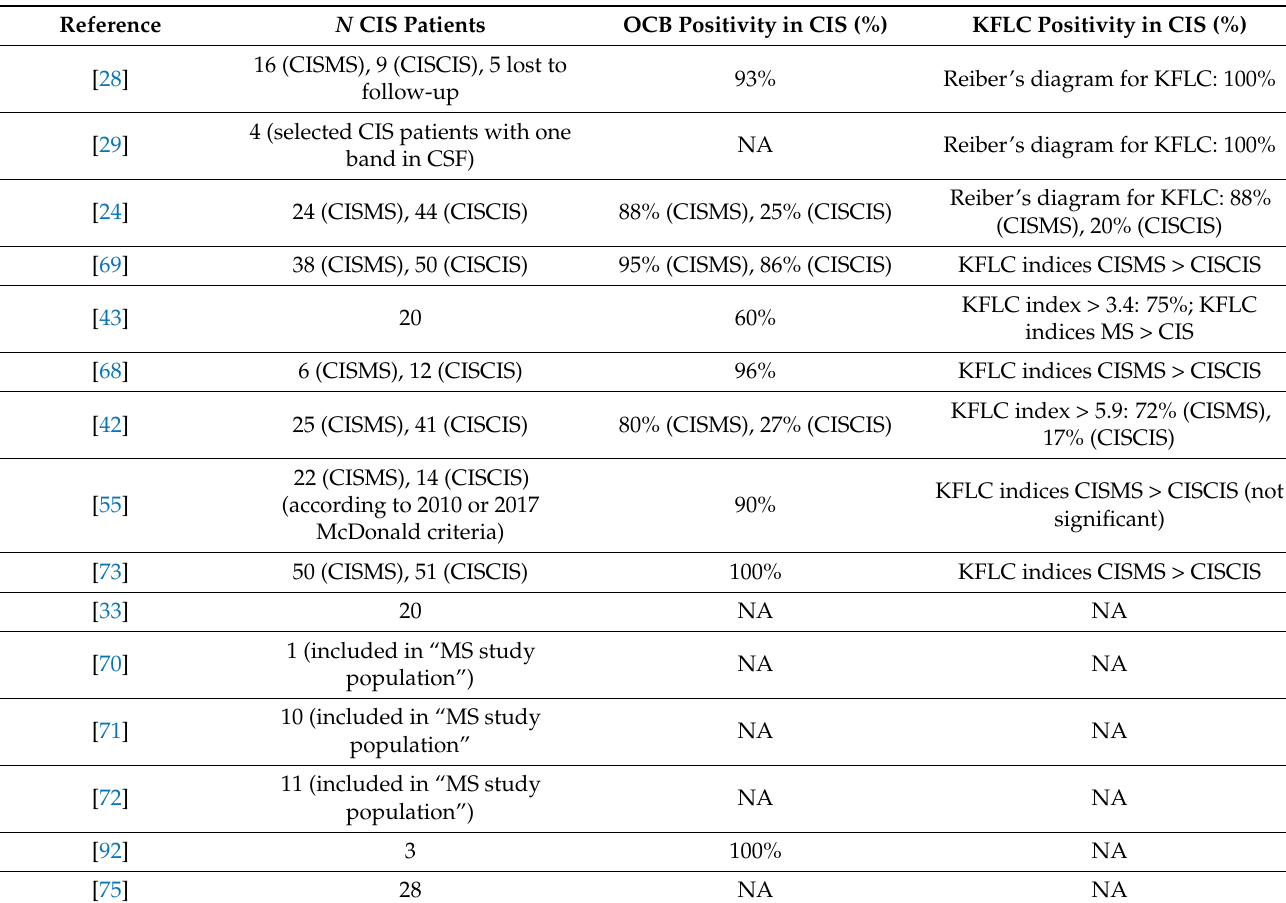
Table 4. Kappa free light chain (KFLC) determination in clinically isolated syndrome (CIS) patients according to the revised McDonald criteria of